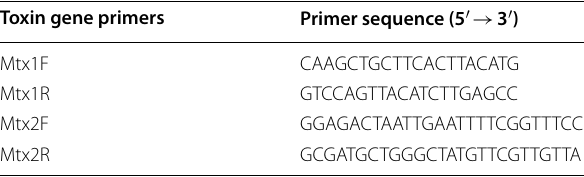
Table 1 Primers used for toxin gene sequencing Toxin gene primers Primer sequence (5 ′